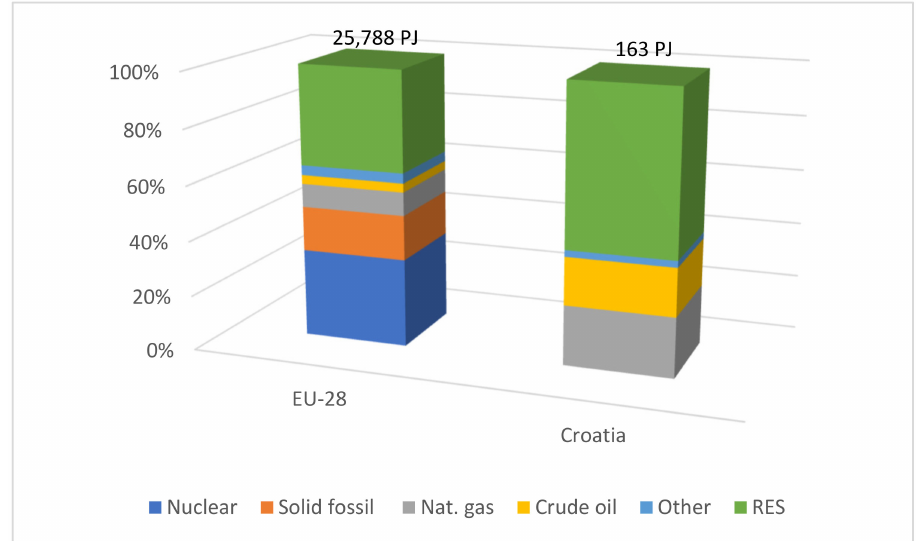
Figure 2. Production of primary energy in Croatia and EU in 2019. Source: Authors’ elaboration based on [7].